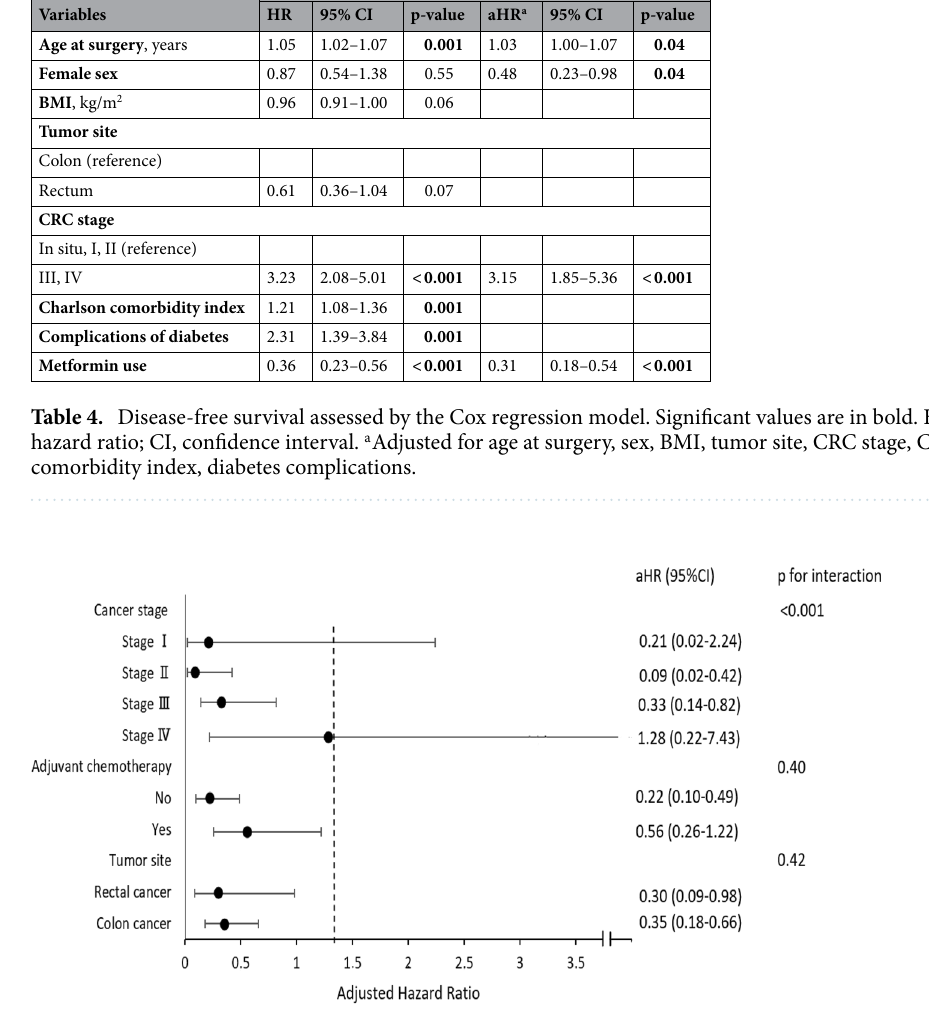
Figure 3. Forest plot for subgroup analysis: effect of metformin on disease-free